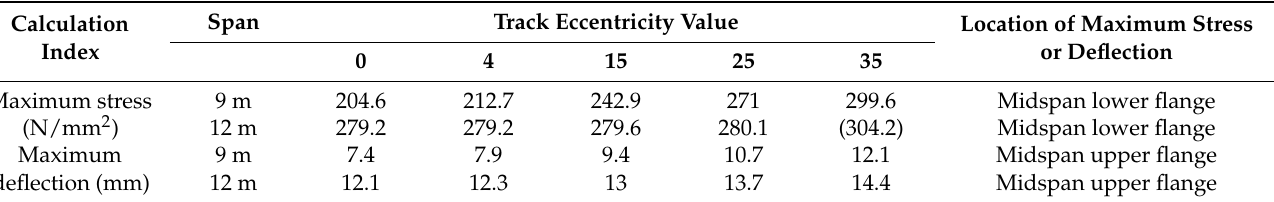
Table 6. Finite element calculation results for crane beam.